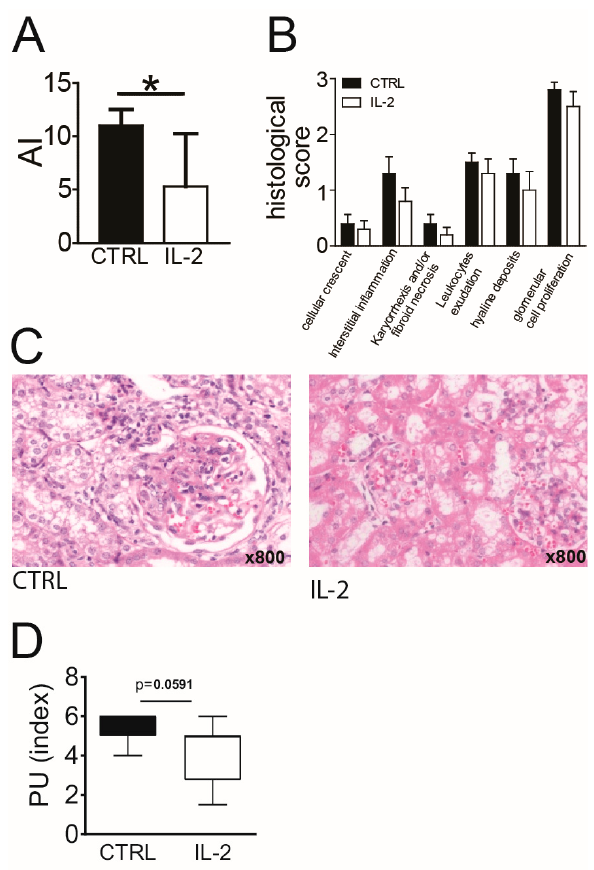
Figure 6. Long-term IL-2 treatment reduces nephritic activity at a histological level. ( A ) The renal activity index (AI) was determined in single kidneys from (NZB × NZW) F1 mice with established nephritis at day 31 after the initiation of the IL-2 treatments (48 h after the last IL-2 injection; IL-2, white bars) and compared to PBS-treated control mice (CTRL, black bars). ( B ) The six differentially weighted histomorphological scores according to the AI are shown for the control and the IL-2 treated group. ( C ) Representative images of hematoxylin and eosin stained kidney sections from either controls (left) or from IL-2 treated mice (right) are shown. ( D ) The proteinuria index of controls and IL-2 treated mice at day 31 are shown. Data represent the mean + SD of the scores summarized from two to five independent experiments ( n = 6–17). Mann-Whitney U test was used for statistical analyses (* p < 0.05 and ** p < 0.01). One outlier in the CTRL group at d0 was identified and removed after using the ROUT test.